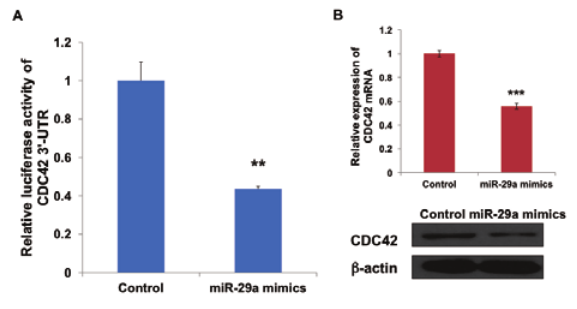
Figure 3: CDC42 might be a natural target of miR-29s. (A) Dual luci- ferase assay results. MDA-MB-453 cells were co-transfected with the recombinant firefly-luciferase plasmids containing CDC42 3’-UTR and miR-29a mimics or controls. The firefly luciferase activities were normalized by the Renilla luciferase activities. **: P<0.01. (B) The expression levels of CDC42 proteins determined by Western blot. The expression levels were represented by the band intensities normalized by those of β